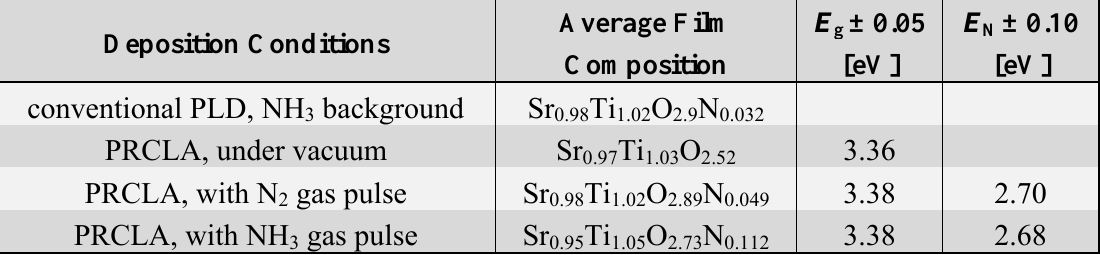
films grown under different deposition 3